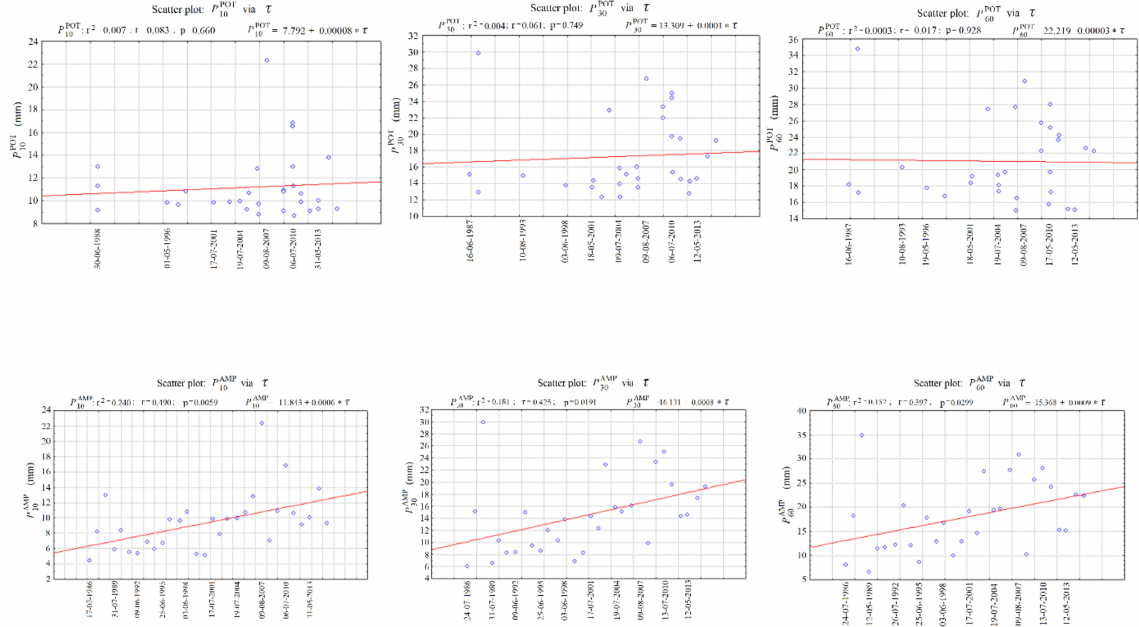
Figure 3. Scatter plots of dependent random variables observed at the Bialystok station: P POT P AMP with respect to the independent variable time ( τ ), with indication of the simple regression equation, coefficient of deter- 60 mination ( r 2 ), linear correlation coefficient ( r ), and test probability ( p ) compared with the assumed significance level α <